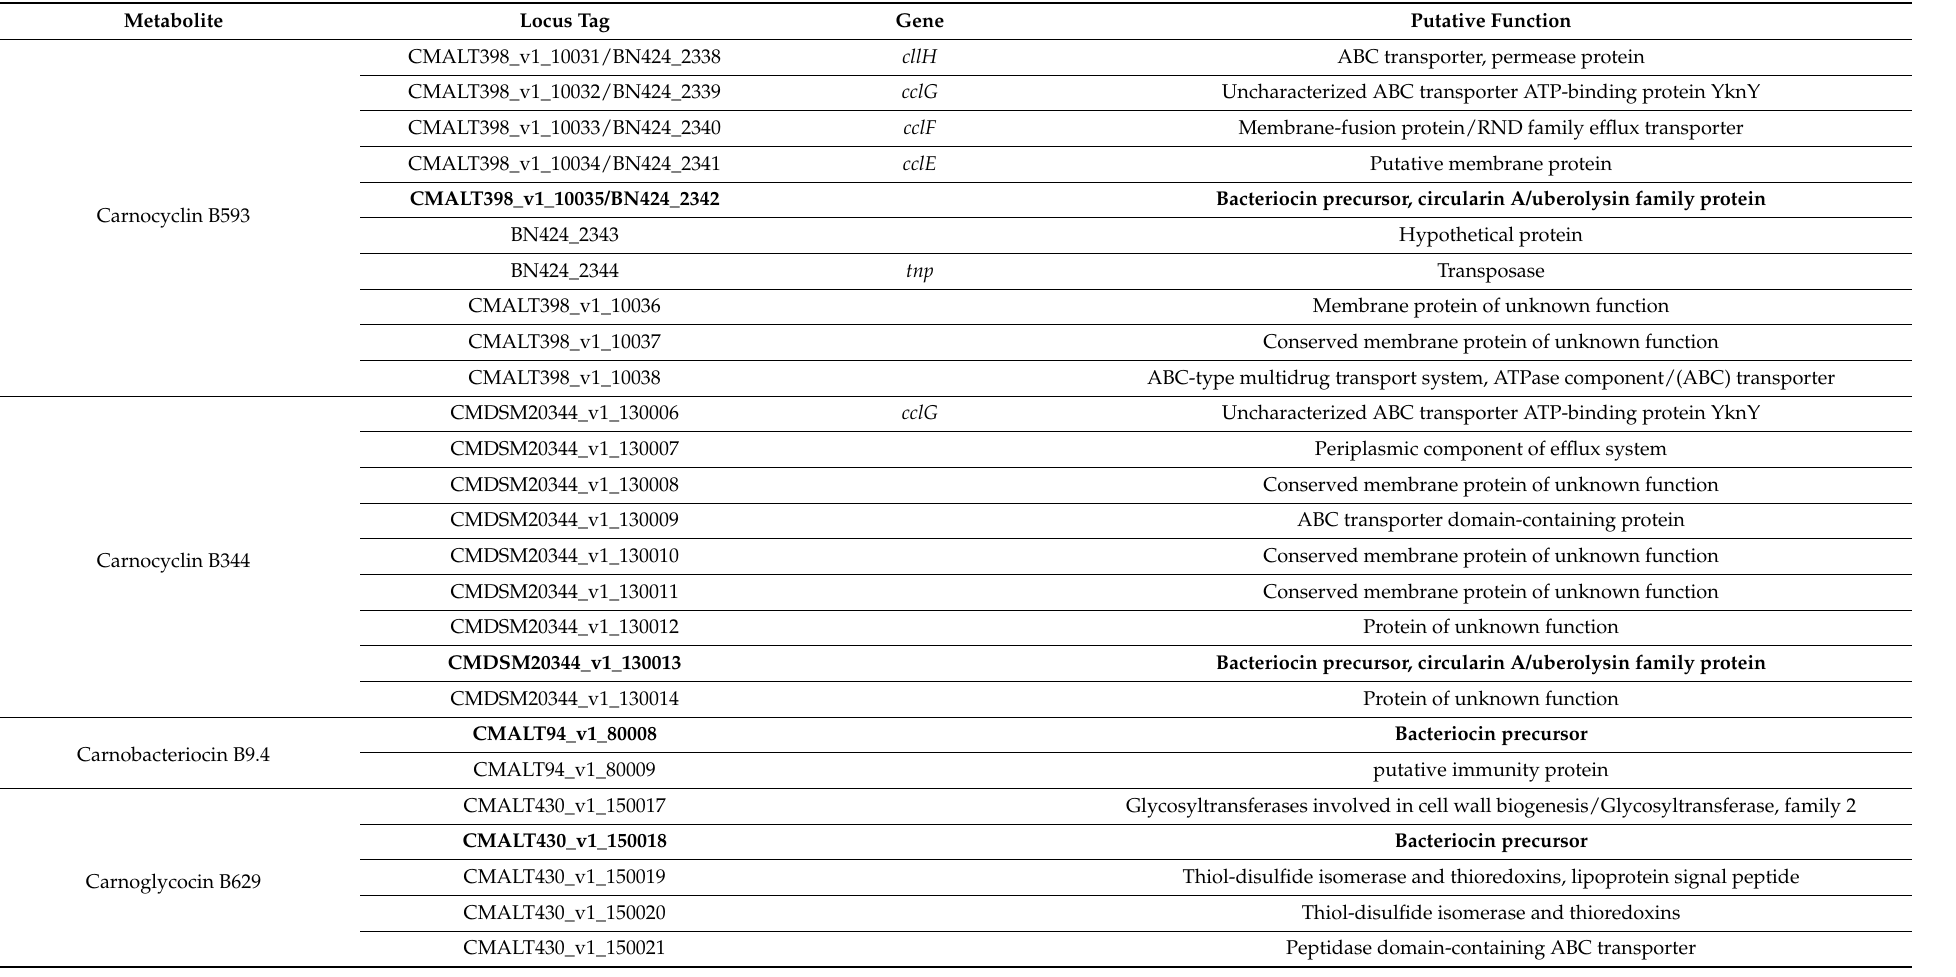
Table 2. BGCs potentially encoding the synthesis of specialized